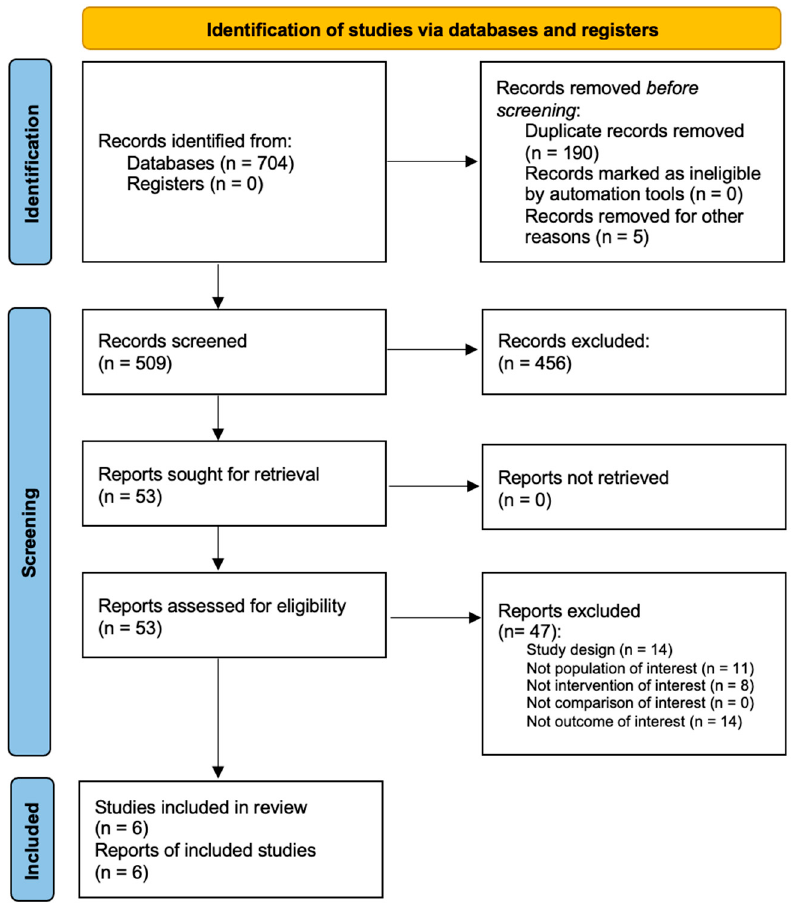
Figure 1. Flow chart of the included studies.